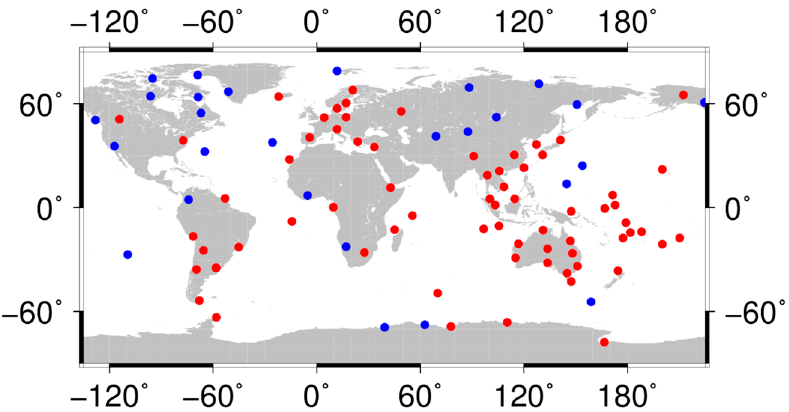
Figure 3. Distribution of stations used in the POD experiment (red: GPS + BDS stations, blue: GPS-only